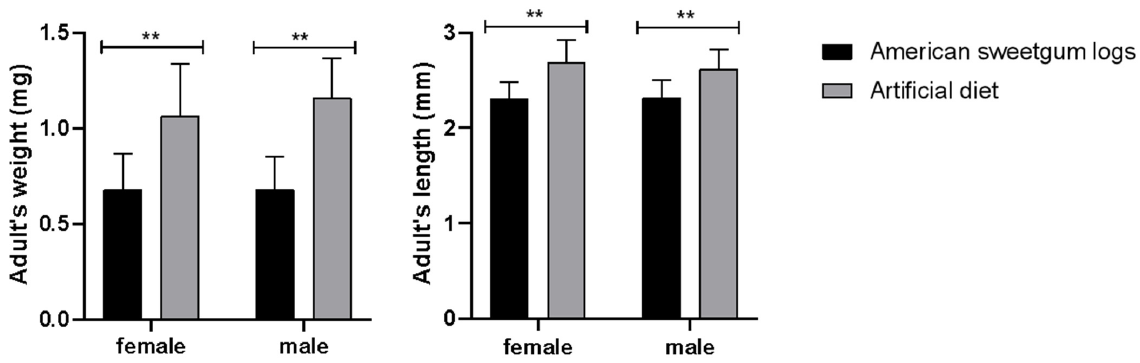
Figure 3. Differences in weight and length between males and females of Acanthotomicus suncei reared on the artificial diet and American sweetgum logs. Mean ± SD, ** p < 0.01. Table 3. Comparison of egg hatching rate, pupation rate, and eclosion rate of Acanthotomicus suncei reared on American sweetgum logs and the artificial diet.